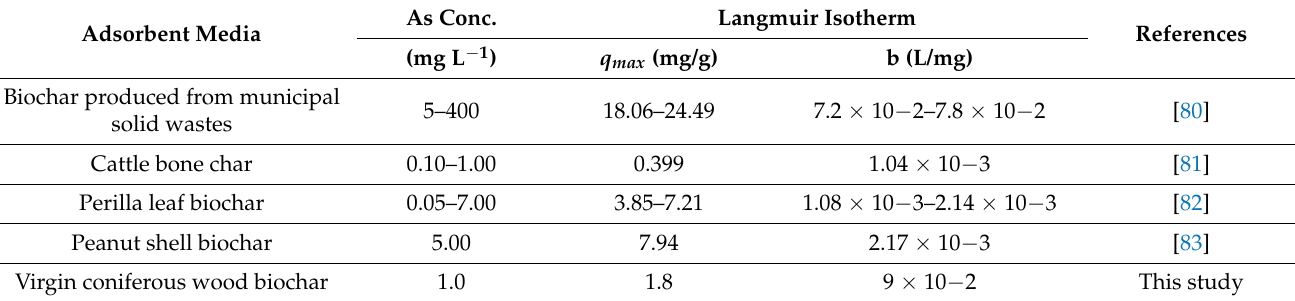
Table 4. Values of Langmuir isotherm parameters for different types of biochar reported in the literature. As Conc. Adsorbent Media